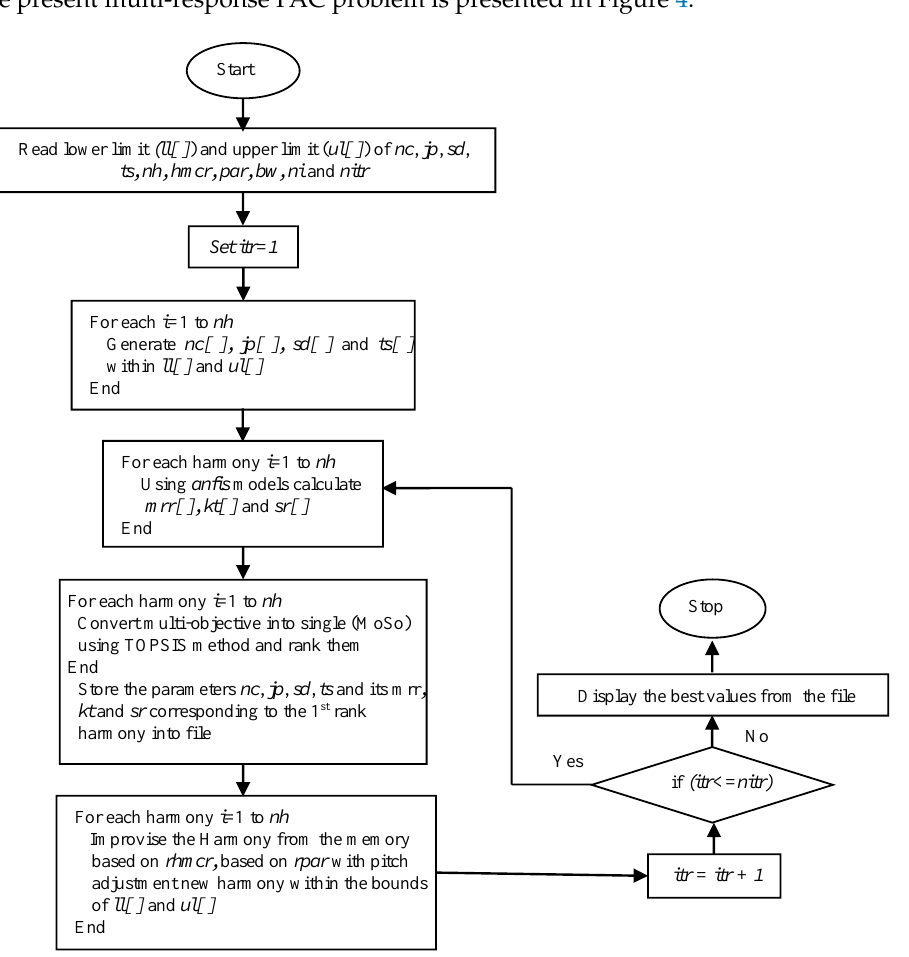
Figure 4. Implementation of the ABC algorithm for multi-response optimization.